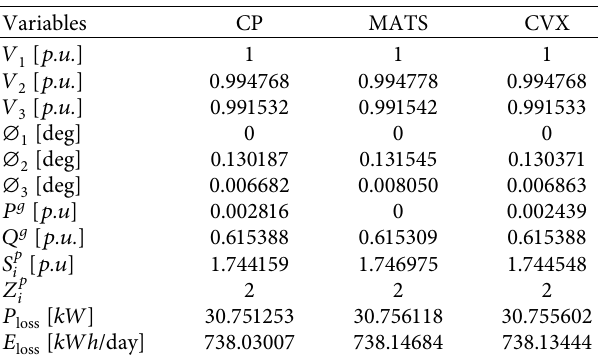
Figure 3: Voltage magnitude (a) and phase (b) plot for simulation 1B. Table 5: Results for simulation 2A.